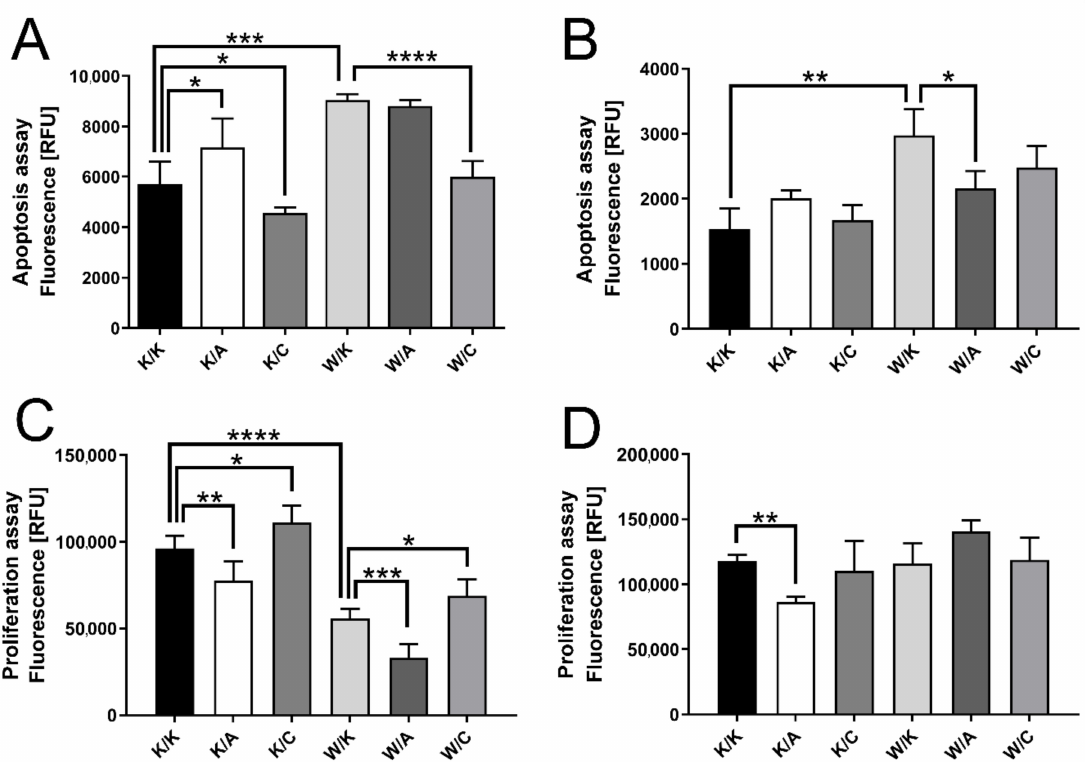
Figure 4. Differences between apoptotic and proliferative potential. ( A ) Apoptosis in HT-1376. ( B ) Apoptosis in CAL-29. ( C ) Proliferation in HT-1376. ( D ) Proliferation in CAL-29. p < 0.05 (*), p < 0.01 (**), p < 0.001 (***), p < 0.0001